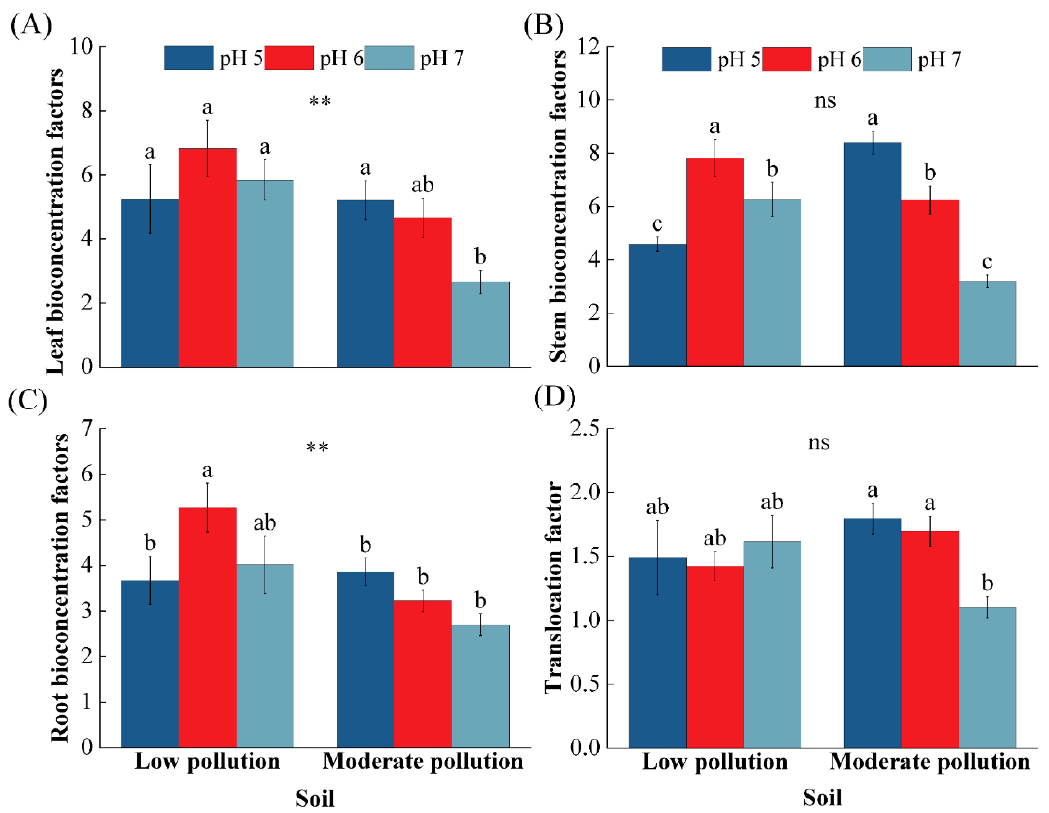
Figure 4. The bioaccumulation factors of leaves ( A ), stems ( B ), roots ( C ), and the translocation factor of Polygonum hydropiper ( D ) under three soil pH values at two cadmium (Cd) contamination levels. Different lowercase letters indicate significant differences between different pH treatments. The ** and ns symbols indicate differences between two soil Cd levels (** p < 0.01, ns p > 0.05).